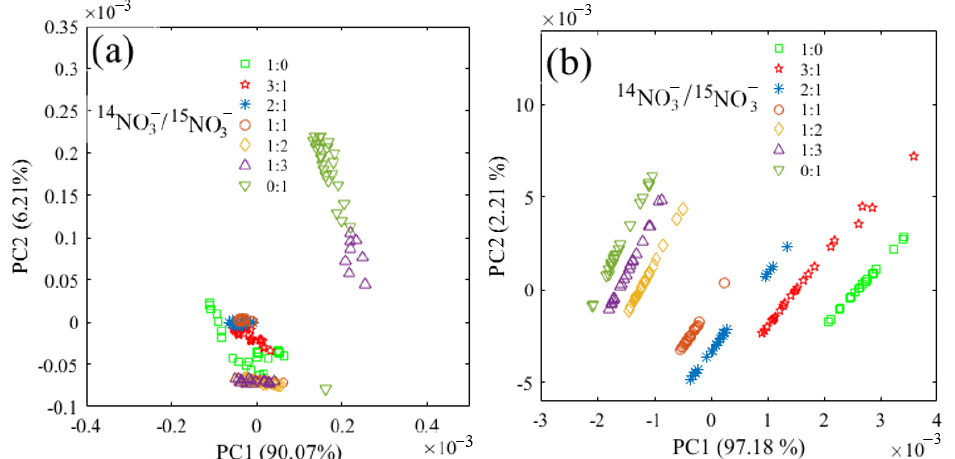
Figure 3. Principal component distribution based on the spectra in the range of 1500–1200 cm − 1 for the nitrate mixture with different 14 N/ 15 N ratios. ( a ) water deduction algorithm; ( b ) deconvolution algorithm.